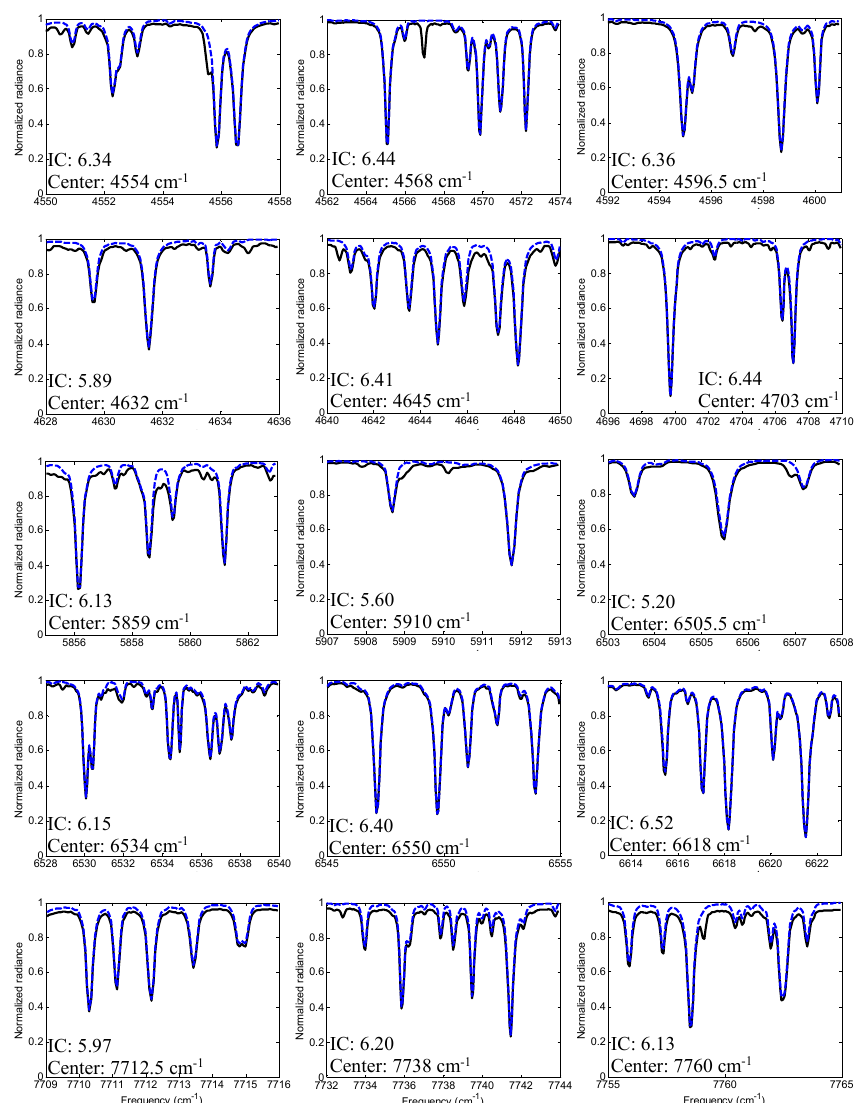
Figure 2. The normalized radiances, obtained by dividing the spectra by the maximum radiance, of the 15 H 2 O absorption bands selected for retrieving H 2 O SCDs from CLARS-FTS measurements. These radiances are spectral fits using the CLARS-FTS measurements in western Pasadena on 1 March 2013 with a solar zenith angle (SZA) of 41.45 ◦ . Solid black curves are fits to the spectra, including contributions of all trace gases and solar lines, from spectral measurements by the FTS, and dashed blue curves are the estimated contribution of H 2 O absorption to the spectral fits. Contributions of other species in these spectral regions are not shown. Central wavelength and information content (IC) value of each band used for retrieving H 2 O content are also